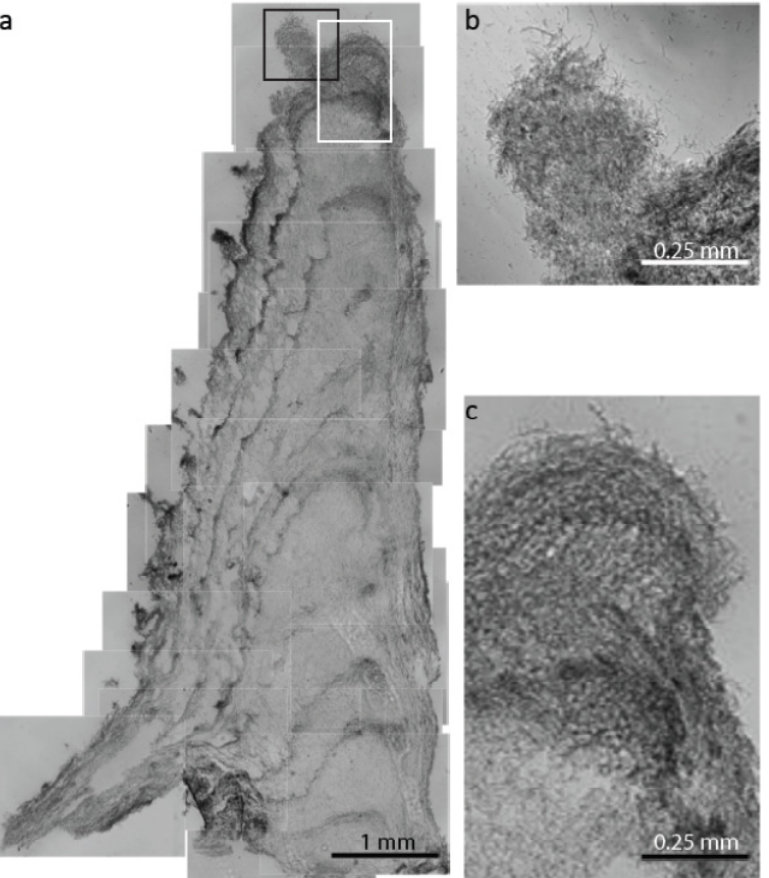
Figure 8. Clumps in a cyanobacterial cone from Yellowstone National Park. ( a ) Mosaic light micrographs of the vertical thin section through the cone. The black and white rectangles, respectively, outline areas with clumped filaments in the tip of the cone which are magnified in ( b ) and ( c ),